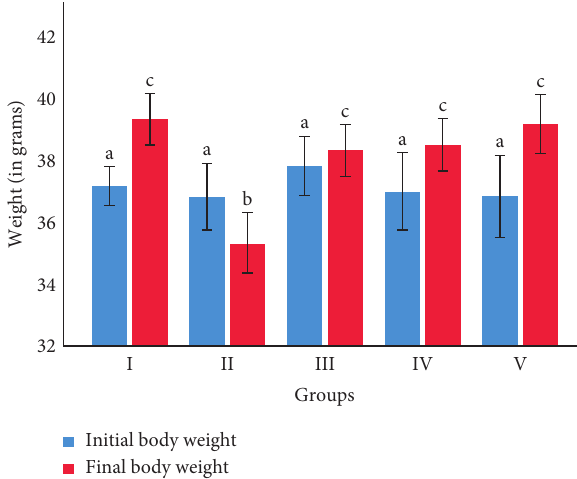
Figure 1: Initial and final body weight of the mice (in grams). The values were expressed as mean ± SD. The sample size is 6 for each group. I: normal control group; II: negative control group; III: received 100mg/kg/day of green coffee beans; IV: received 200mg/ kg/day of green coffee beans; and V: received 300mg/kg/day of green coffee beans, respectively. Values with different letters within the same color are statistically significantly different at p < 0 . 05 as tested by Tukey post hoc multiple